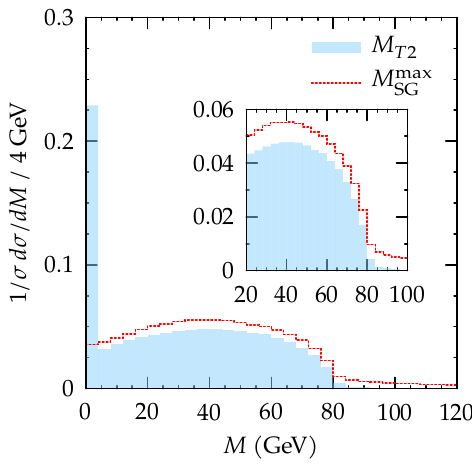
Figure 6 . Distributions of M T 2 and M max in the WW subsystem of top pair process. The insert SG in the plot shows the distributions in the mass region between 20 and 100